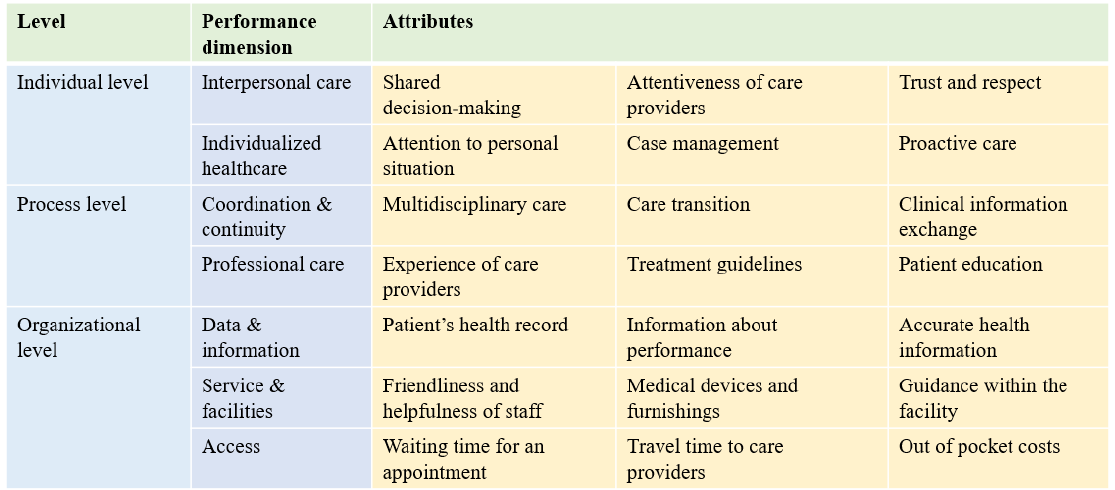
Figure 1. Framework of people-centered integrated care delivery (Mühlbacher, 2013).